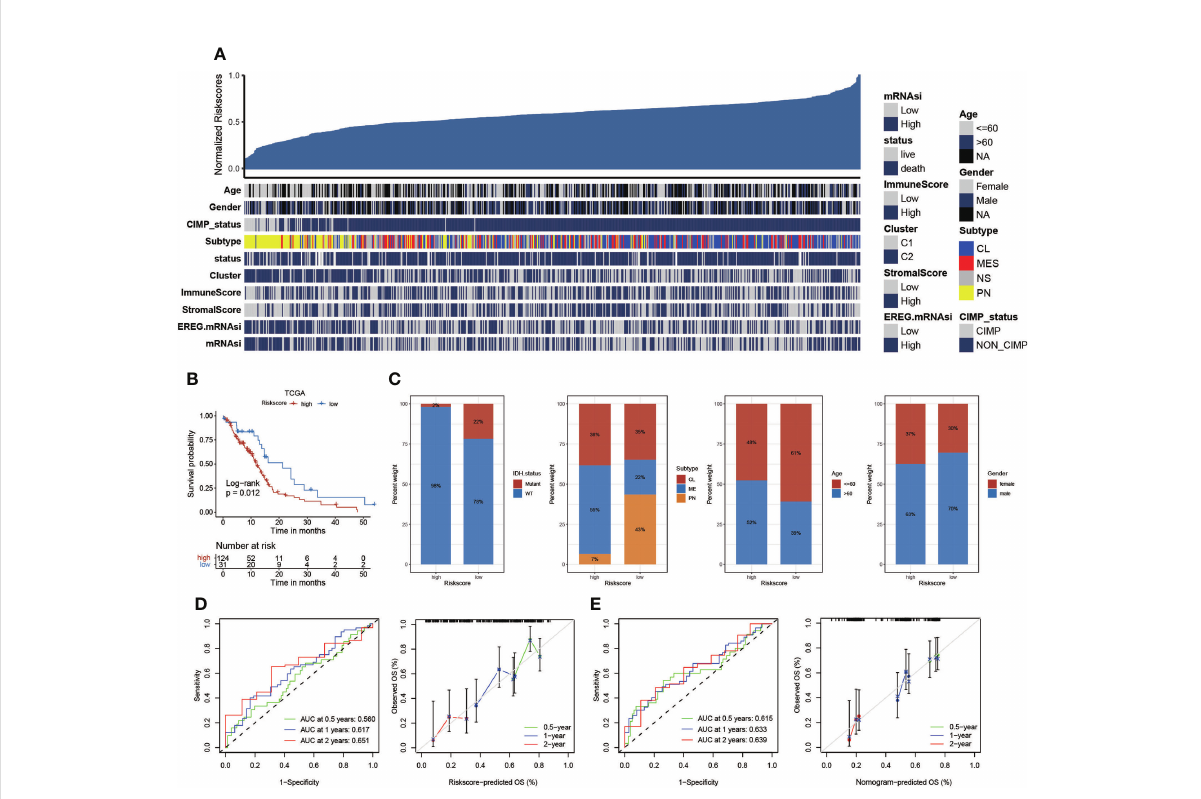
FIGURE 6 The risk score based on TCGA datasets. (A) The relationship between risk scores and clinical characteristics. (B) Kaplan – Meier curves of the risk score based on TCGA datasets (p = 0.012, log-rank test). (C) The proportion of clinical characteristics in high- and low-risk scores. (D) The AUC of the 1-, 2-, and 3-year survival rate of GBM and validation of the ROC of the risk score. (E) The AUC and validation of the ROC of the nomogram